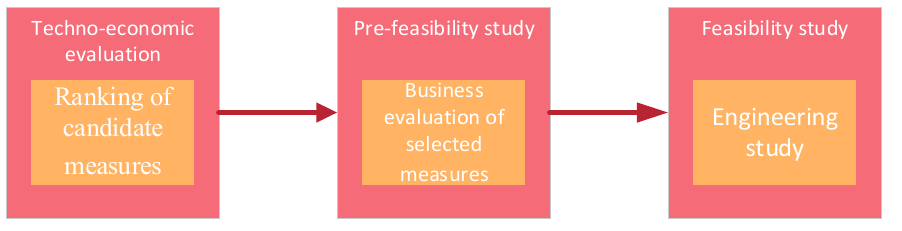
Figure 1. Decision-making process for process development projects.